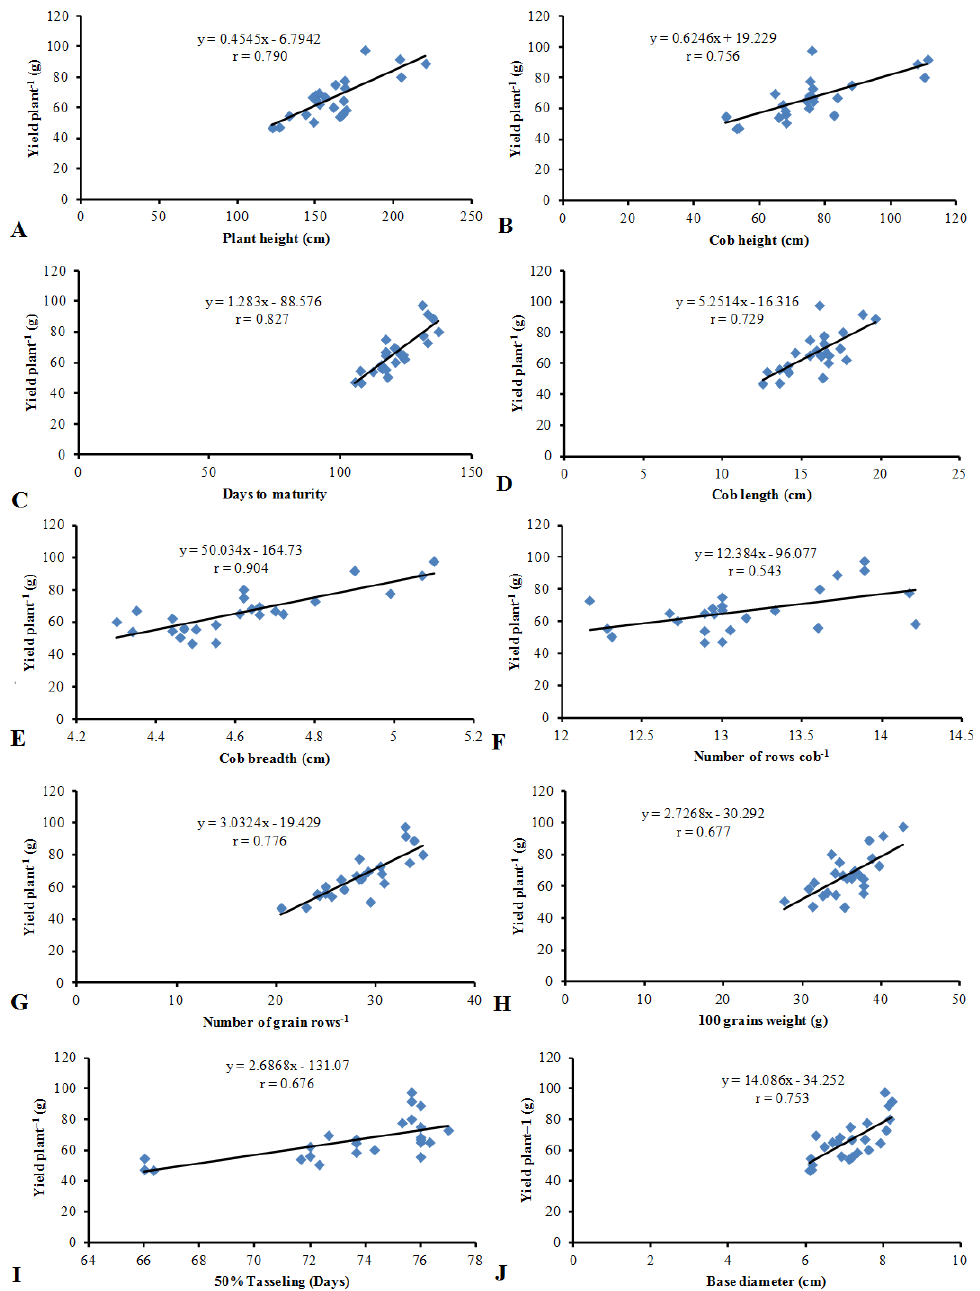
Fig. 3. Correlations between yield plant -1 and yield contributing traits of twenty-four F 3 populations of white maize.: A) plant height; B) cob height; C) days to maturity; D) cob length; E) cob breadth; F) rows cob -1 ; G) number of grains -1 ; H) 100 grains weight; I) 50% tasseling; J) base